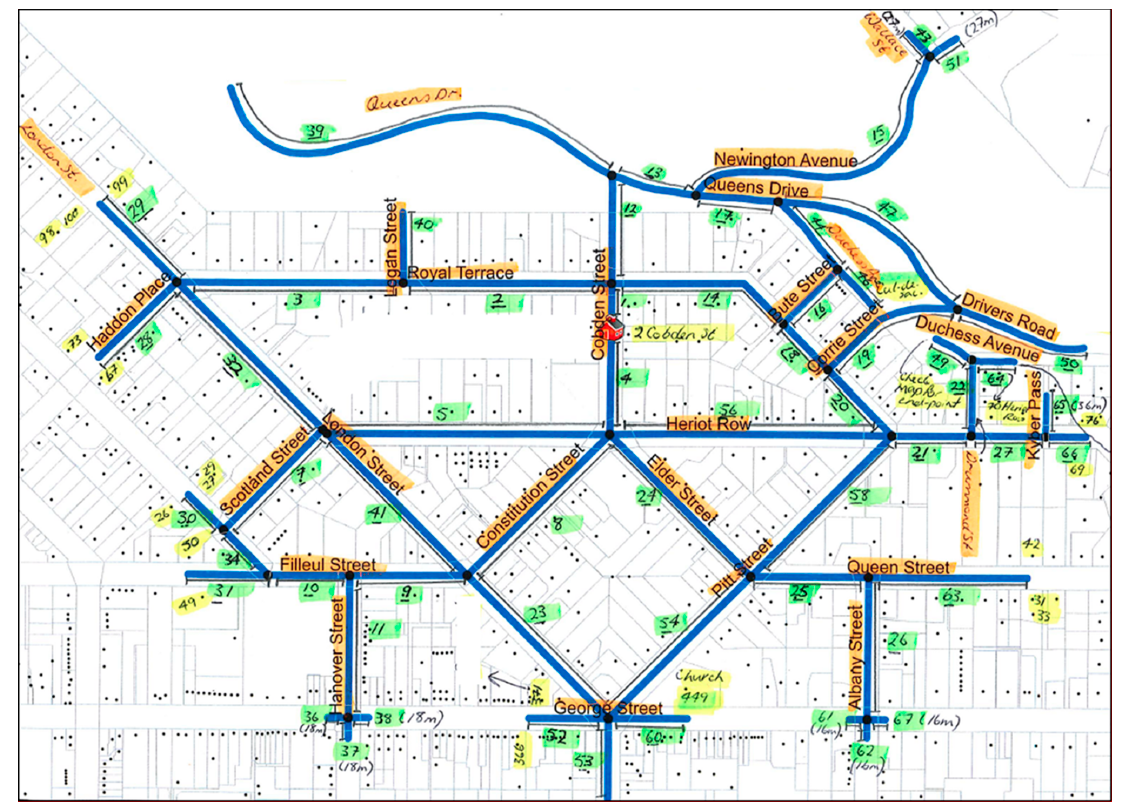
Figure 1. Example worksheet of the 0.5 km street network buffer-zone (blue lines) used for conducting route and segment MAPS Global audits. Note. Green highlighting refers to the identifying code of the segment; yellow highlighting refers to a street address point; black dots refer to residences.